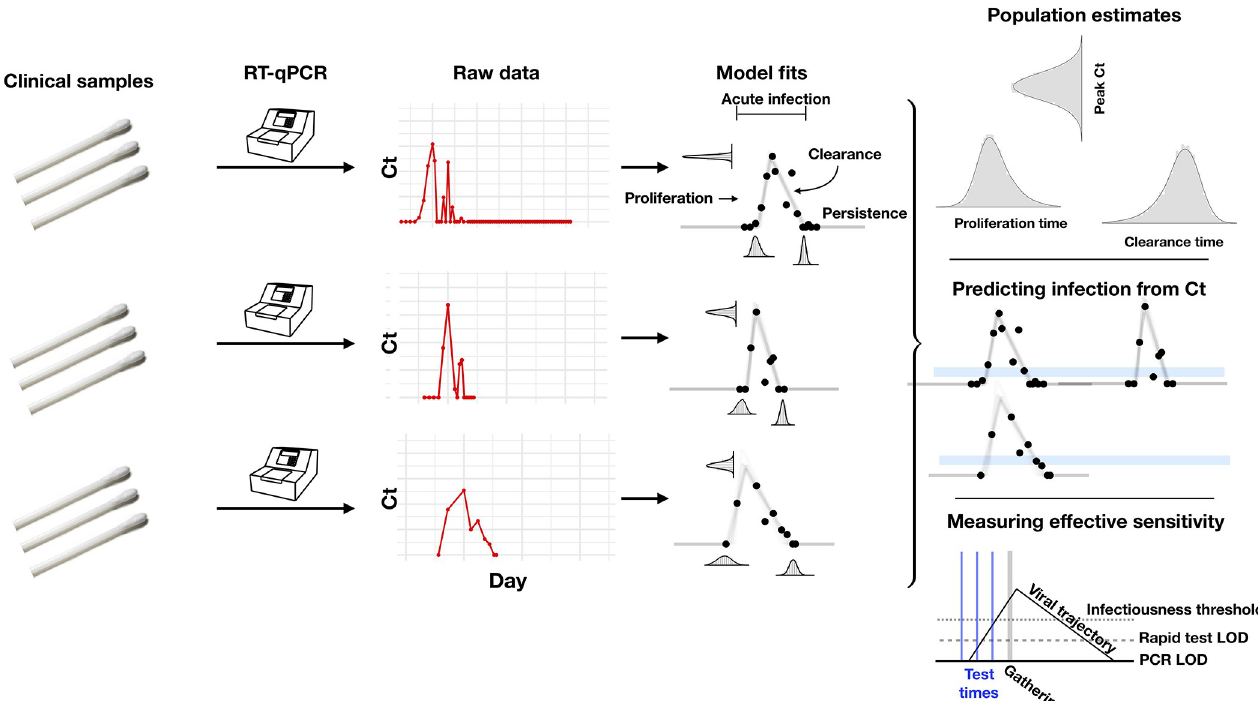
Fig 1. Illustration of the analysis pipeline. Combined anterior nares and oropharyngeal swabs were tested using a RT-qPCR assay to generate longitudinal Ct values (“Raw data”; red points) for each person. Using a statistical model (see S6 Fig for a schematic of the model), we estimated Ct trajectories consistent with the data, represented by the thin lines under the “Model fits” heading. These produced posterior probability distributions for the peak Ct value, the duration of the proliferation phase (first potential detectability of infection to peak Ct), and the duration of the clearance phase (peak Ct to resolution of acute infection) for each person. We estimated population means for these quantities (under the heading “Population estimates”). The model fits also allowed us to determine how frequently a given Ct value or pair of Ct values within a 5-unit window (blue bars, under the heading “Predicting infection from Ct”) was associated with the proliferation phase, the clearance phase, or a persistent infection. Finally, the model fits allowed us to measure the “effective sensitivity” of a test for predicting future infectiousness. The schematic illustration titled “Measuring effective sensitivity” depicts the relationship between testing lags and the ability to detect infectious individuals at a gathering. The illustrated viral trajectory surpasses the infectiousness threshold (dotted line) at the time of the gathering (vertical grey bar), so unless this individual is screened by a pre-gathering test, he or she would attend the event while infectious. One day prior to the gathering, the individual’s infection could be detected by either a rapid test or a PCR test. Two days prior to the event, the individual’s infection could be detected by a PCR test but not by a rapid test. Three days prior to the event, neither test would detect the individual’s infection. Ct, cycle threshold; LOD, limit of detection; RT- qPCR, quantitative reverse transcription polymerase chain